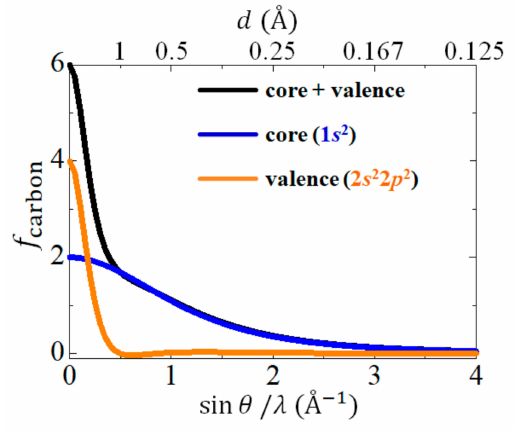
Figure 1. Atomic scattering factor of carbon [15]. Black, blue, and orange lines indicate the contribution of the total, core, and valence electrons,